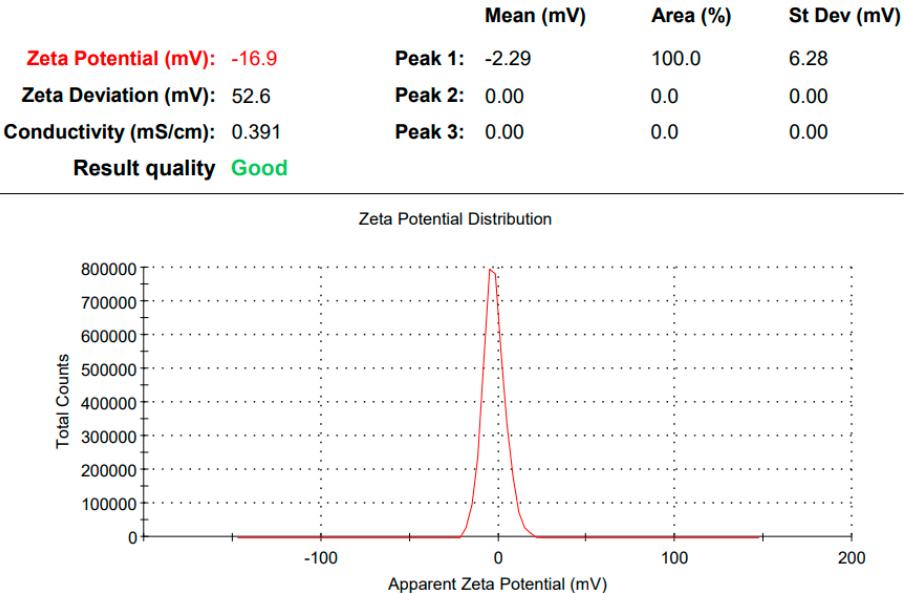
Figure 4. Zeta potential value for AgPtNP is − 16.9.